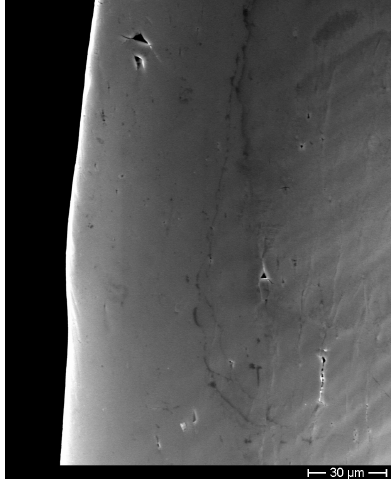
Figure 11: SEM micrographs of instrument number 16. Figure 12: SEM micrographs of instrument number